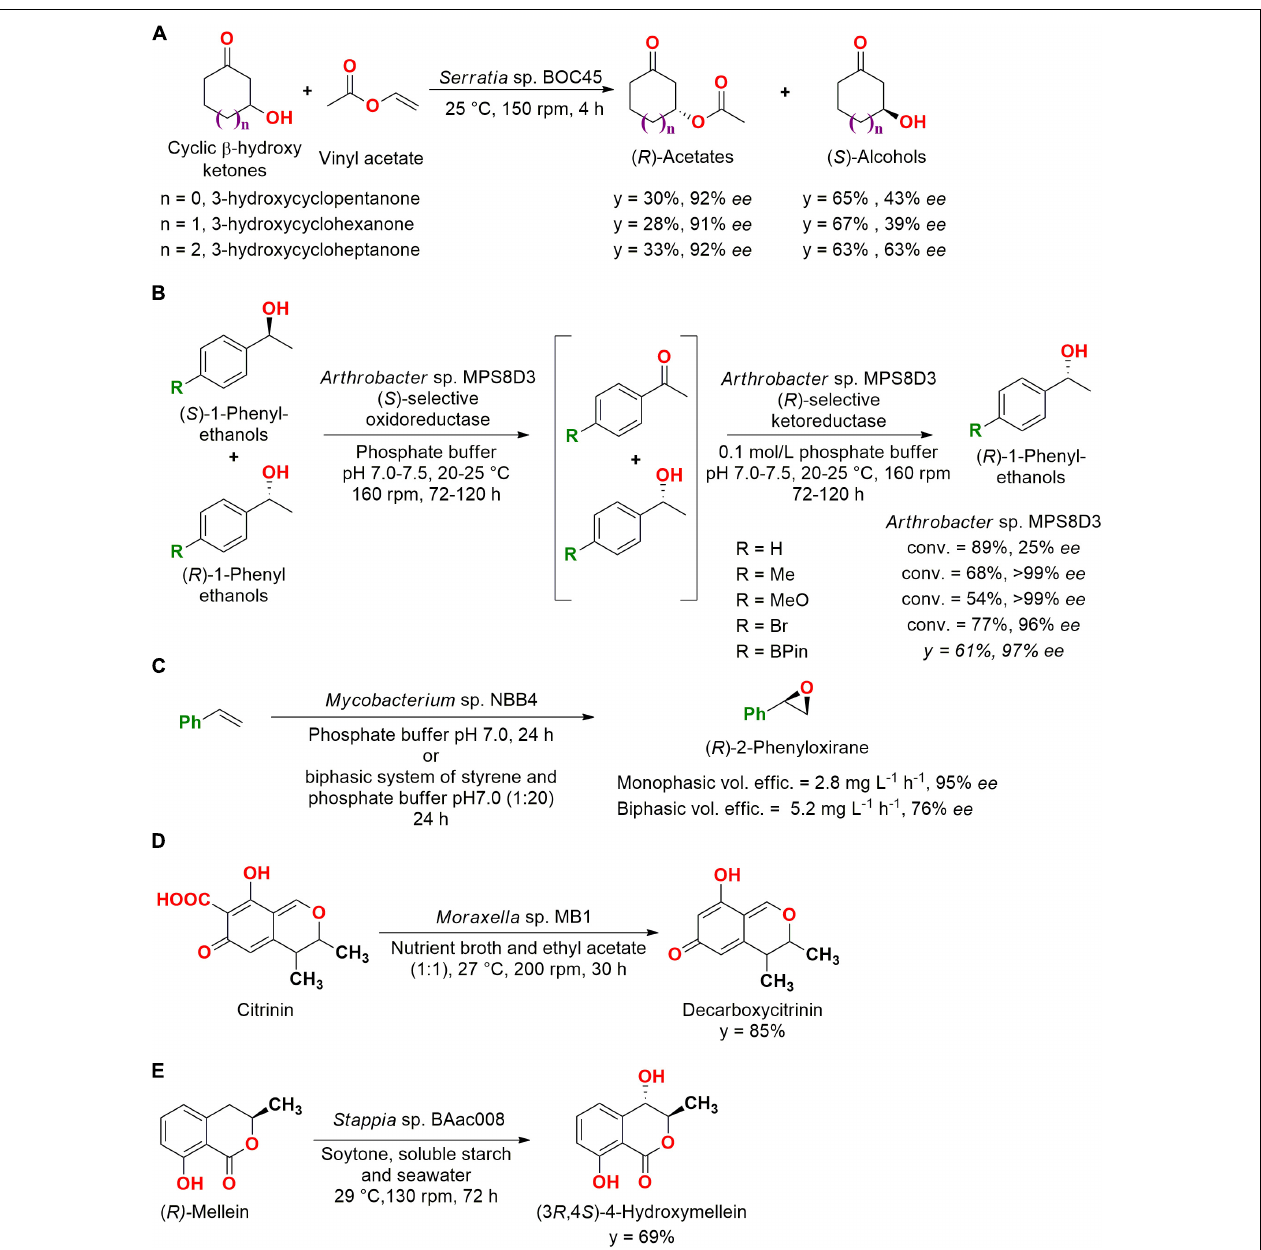
FIGURE 2 | (A) Kinetic resolution reactions of cyclic β -hydroxy ketones by Serratia sp. BOC45 (Chen et al., 2017). (B) Deracemization of 1-phenylethanols, including heteroatoms, by Arthrobacter sp. MPS8D3 (Palmeira et al., 2014). (C) Enantioselective epoxidation of styrene by Mycobacterium sp. NBB4 (Cheung et al., 2013). (D) Decarboxylation of citrinin to decarboxycitrinin by the marine bacteria Moraxella sp. MB1 (Devi et al., 2006). (E) Hydroxylation of ( R )-mellein to (3 R ,4 S )-4-hydroxymellein by Stappia sp. BAac008 (Feng et al.,